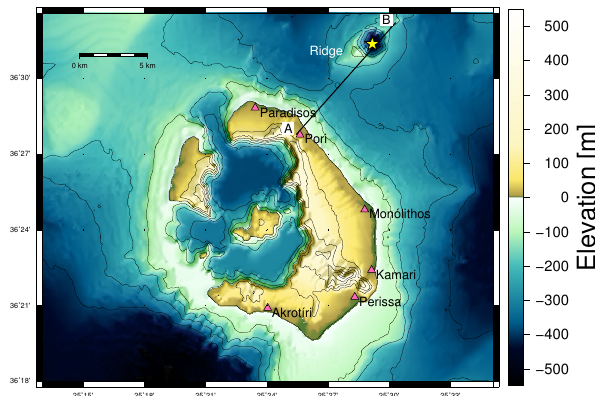
Fig. 2. Bathymetry (negative) and topography (positive) of the San- torini island, Greece, and its surrounding used for numerical simula- tions. Contour lines are depicted with a contour line interval 100m. Kolumbo volcano is represented by the yellow star. Main coastal towns are shown by pink triangles (Modified after Nomikou et al.,